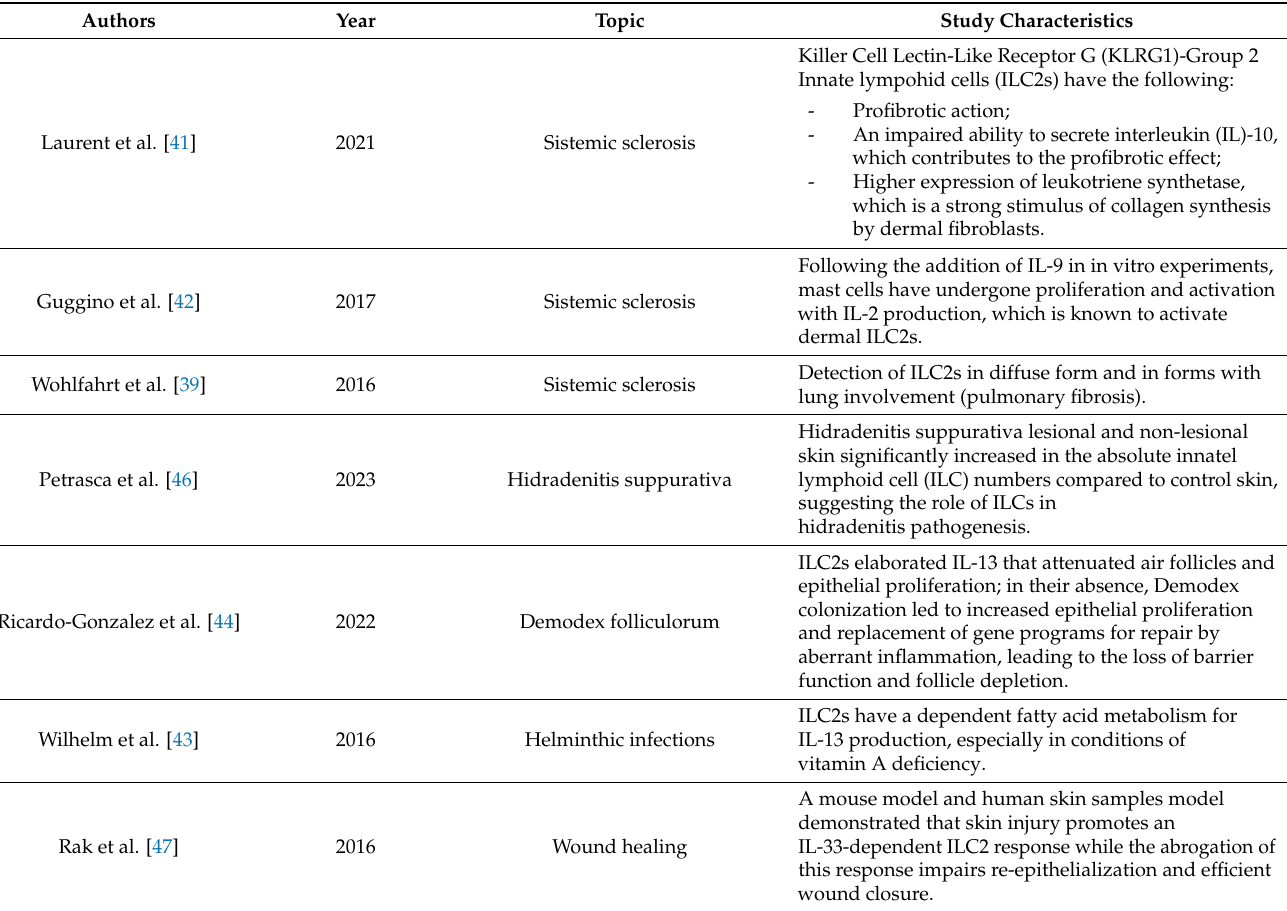
Table 1. The role of ILC2s in inflammatory cutaneous diseases: systemic sclerosis, hidradenitis suppurativa, parasite infections, wound healing, graft versus host diseases, and